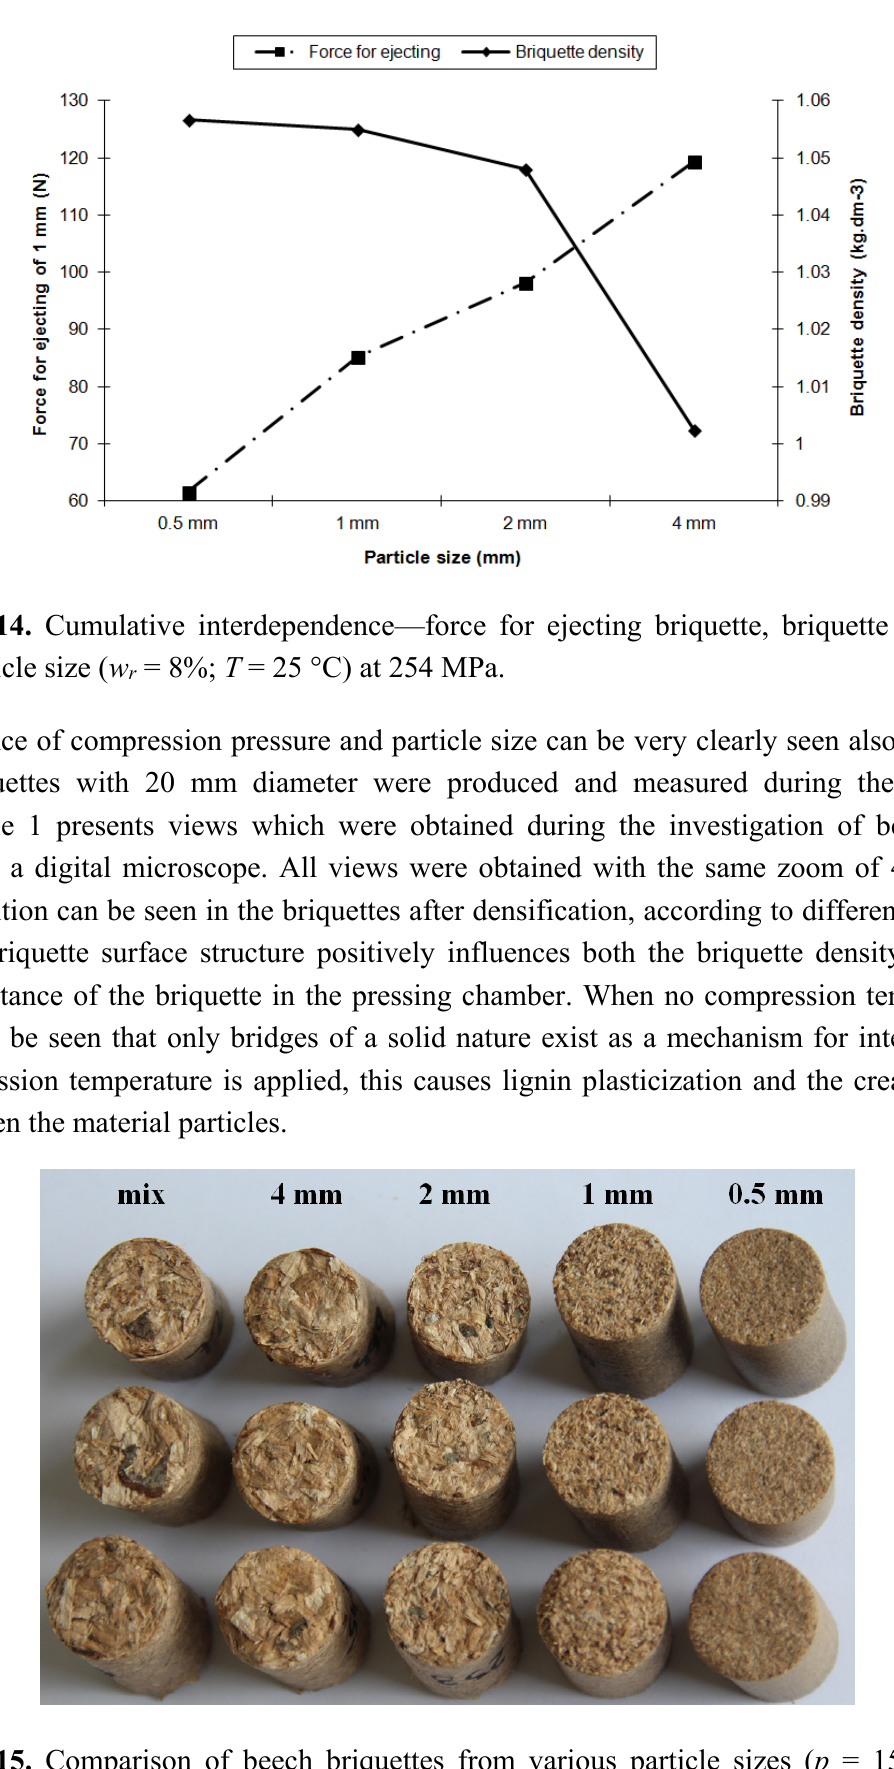
Figure 15. Comparison of beech briquettes from various particle sizes ( p = 159 MPa; w r = 8%; T = 25